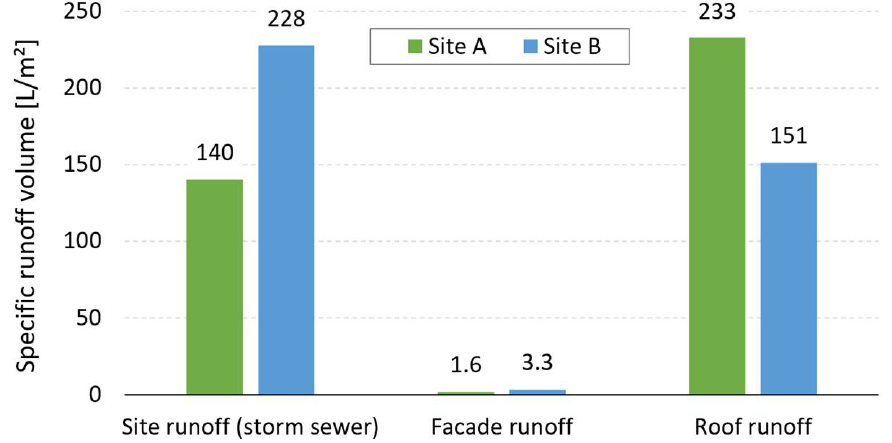
Figure 1. Specific runoff from surfaces drained to the storm sewer resulting from analysed storm events in test sites A and B.